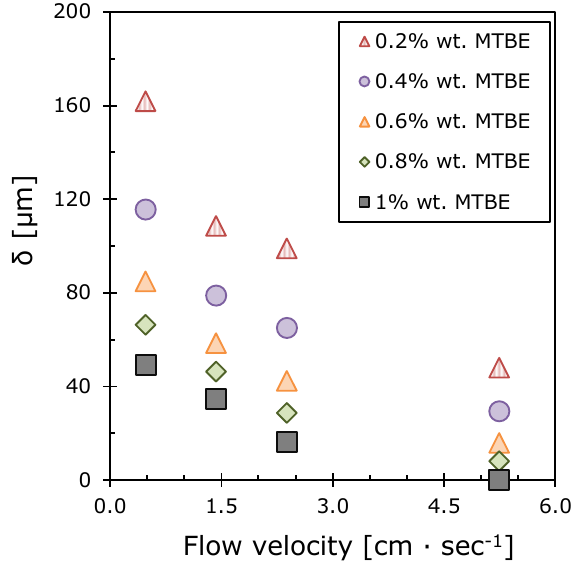
Figure 11. The dependences of the boundary layer thickness on the feed flow velocity at various MTBE concentrations.